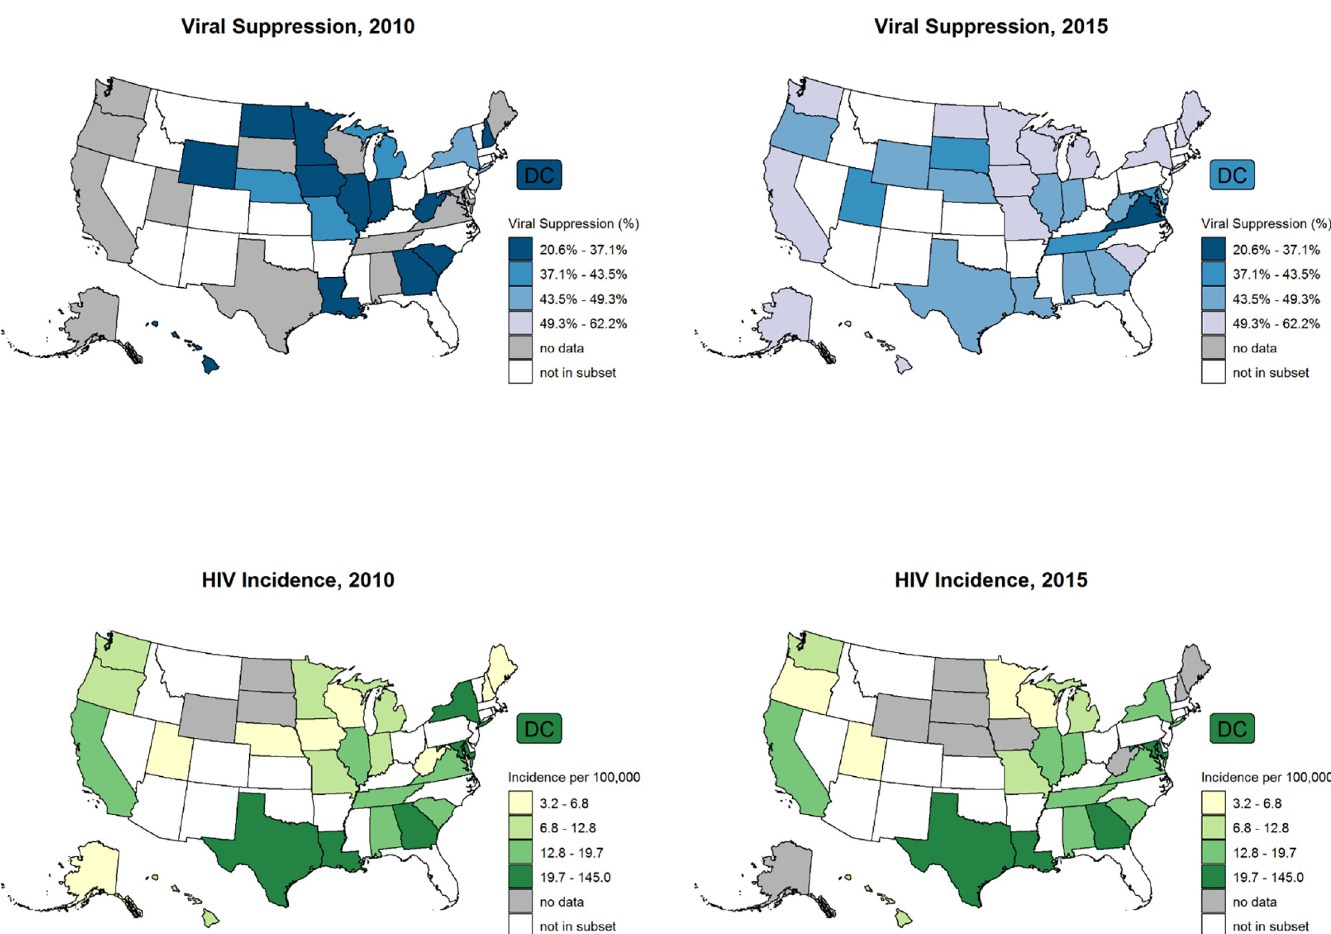
Fig 2. Percentage viral suppression in persons with HIV and estimated HIV incidence in 2010 and 2015, United States. The subset includes 30 jurisdictions (29 states and the District of Columbia) with viral suppression data available for 3 years or more. Estimated HIV incidence rate and percent viral suppression categories were determined by quartiles calculated across the entire time frame